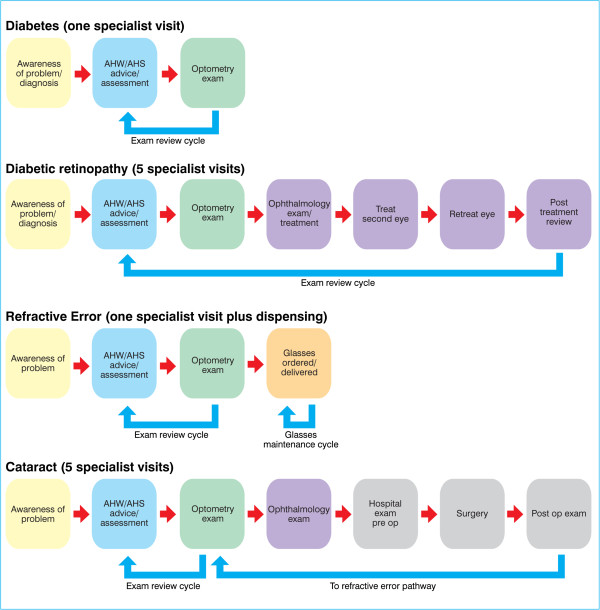
Complexity of the clinical pathway [[1],[2]].